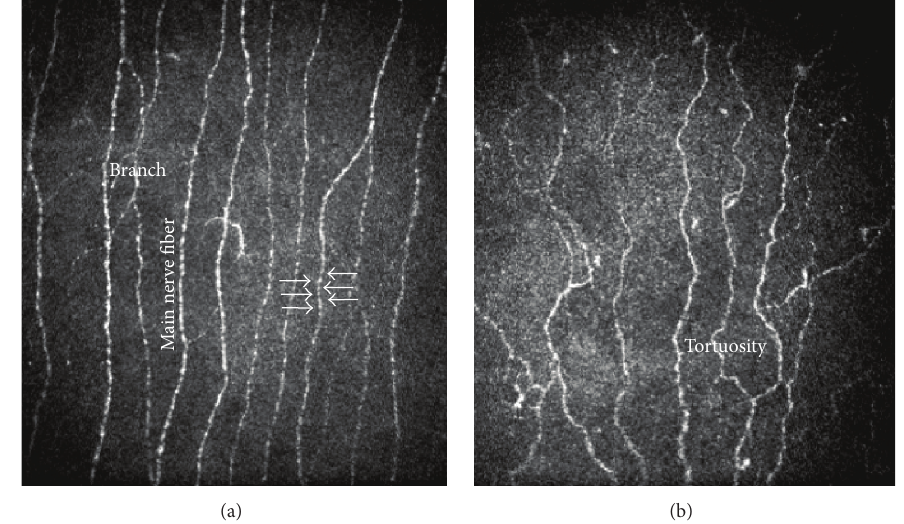
Figure 2: Comparison of the morphology of corneal nerve fibers between a control subject (a) and a patient without neuropathy (b). White arrows indicated